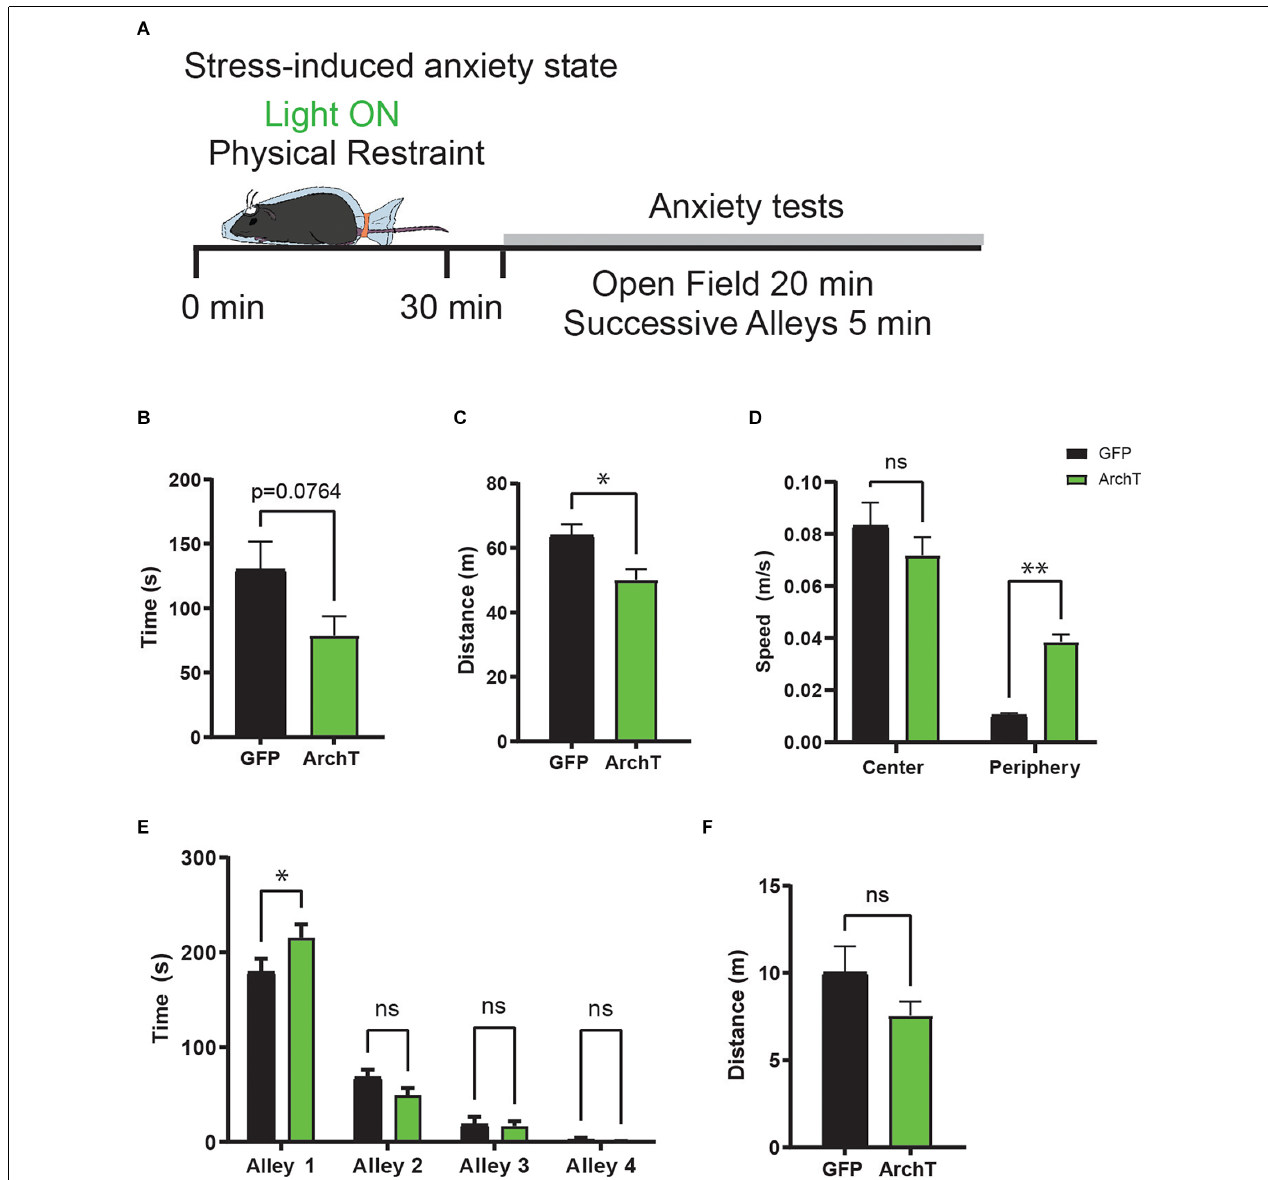
FIGURE 3 | HPC → AHN inhibition during stress increases anxiety behaviors. (A) A cartoon schematic of stress-induced anxiety behavior paradigm. (B) Time spent in the center of open field shows reduced trend (GFP N = 7, ArchT N = 7, unpaired t -test, t = 1.939, df = 12, p = 0.0764, NS). (C) Distance traveled in open field (unpaired t -test, t = 2.924, df = 12, ∗ p = 0.0127). (D) Mean speed (m/s) of centerzone did not differ between ArchT and GFP. Mean speed (m/s) of periphery zone was increased in ArchT mice (2-WAY ANOVA, Zone × rhodopsin, F (1,24) = 11.66, ∗∗ p = 0.0023, zone effect, F (1,24) = 83.45, ∗∗∗∗ p < 0.0001, rhodopsin effect, F (1,24) = 2.121, p = 0.1582, NS, Bonferroni’s multiple comparisons test, CenterArchT vs. GFP, p = 0.358, NS, Periphery ArchT vs. GFP, ∗∗ p = 0.0042). (E) ArchT mice prefer closed alley (alley 1) and avoid open alleys (alley 2–4) compared to GFP (2-WAY ANOVA, Alley × rhodopsin effect, F (3,48) = 3.524, ∗ p = 0.0218, Alley effect, F (3,48) = 207.1, ∗∗∗∗ p = < 0.0001, rhodopsin effect, F (1,48) = 0.2777, p = 0.6007, NS, Bonferroni’s multiple comparisons test, Alley 1 GFP vs. ArchT, p = 0.0221, Alley 2 GFP vs. ArchT, p = 0.5252, NS, Alley 3 GFP vs. ArchT, p > 0.9999, NS, Alley 4 GFP vs. ArchT, p > 0.9999, NS). (F) Distance traveled in successive alleys test (unpaired t -test, t = 1.449, df = 12, p = 0.1731, NS). All results reported are mean ± s.e.m. ∗ p < 0.05, ∗∗ p < 0.01, ∗∗∗ p < 0.001, ∗∗∗∗ p <